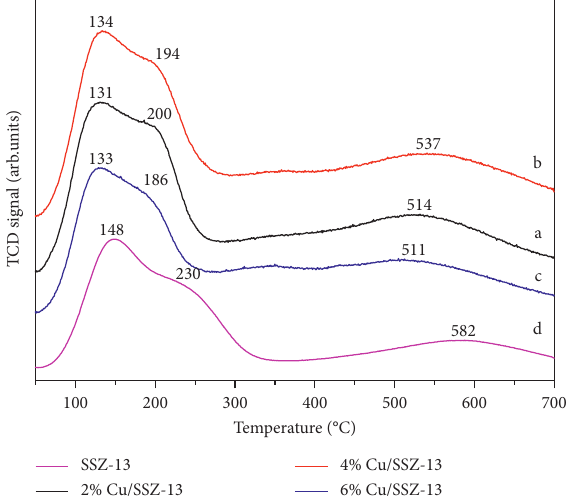
Figure 3: NH 3 -TPD profile of copper-modified SSZ-13 catalysts: (a) 2% Cu/SSZ-13, (b) 4% Cu/SSZ-13, (c) 6% Cu/SSZ-13, and (d) SSZ-13.